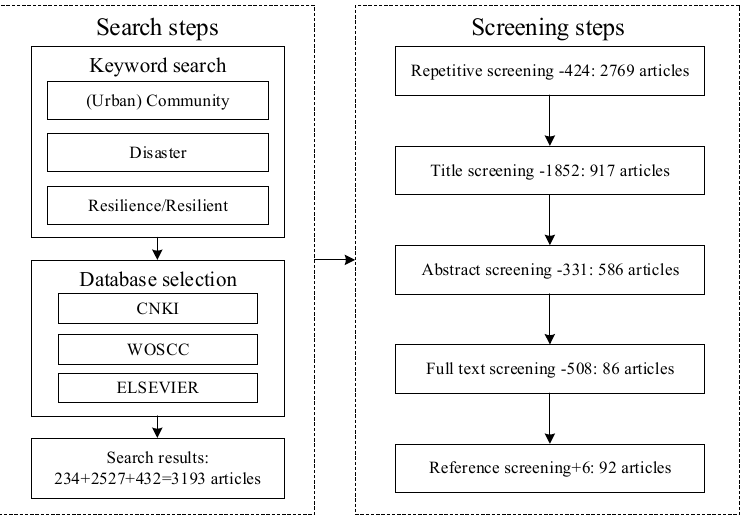
Figure 4. SLR searching and screening process.